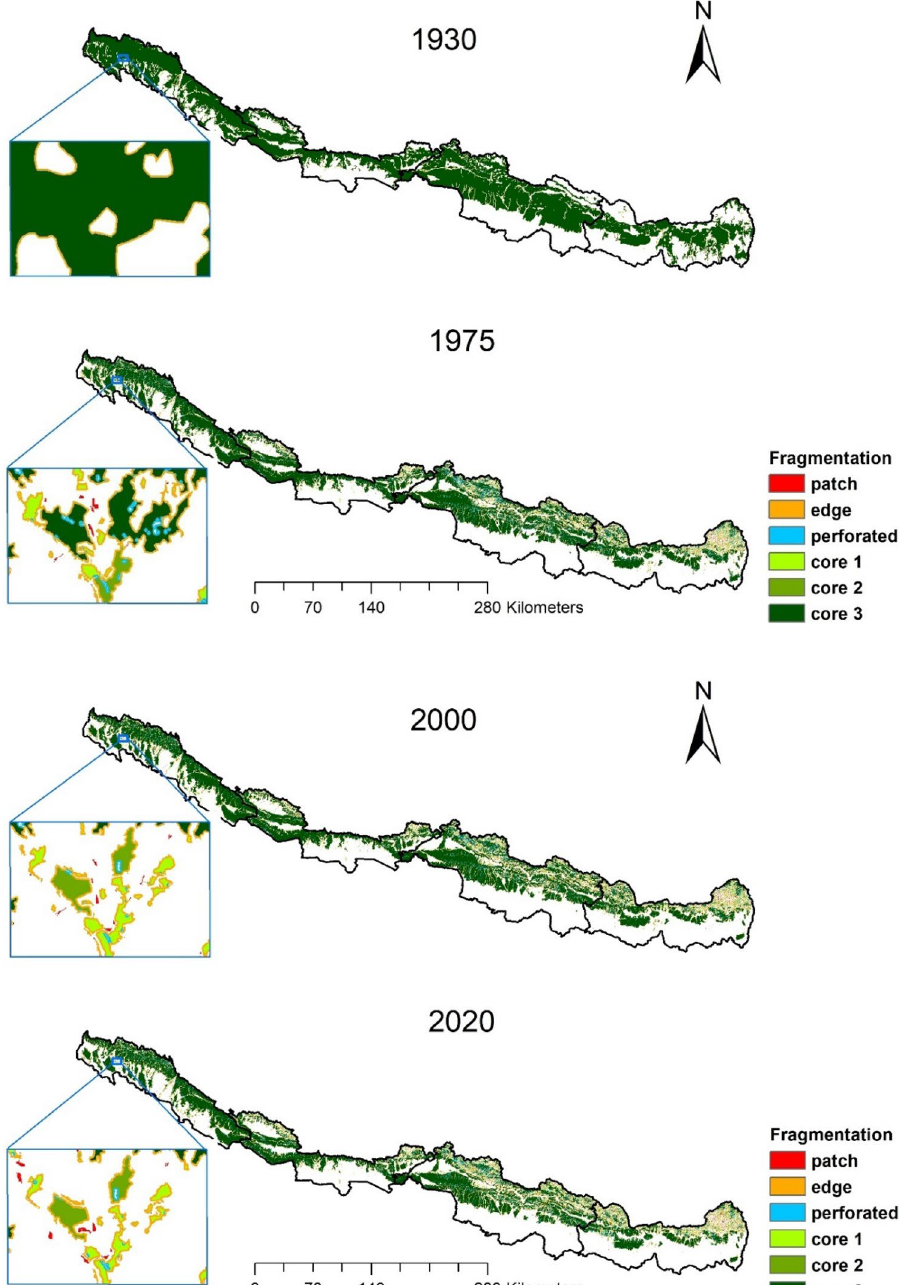
Figure 2. Habitat (forest) fragmentation of Asian elephants in the Chure Terai Madhesh Landscape, Nepal. Inset shows an enlarged view of habitat fragmentation in four different periods (1930, 1975, 2000 and 2020) at that particular location. Map generated by Ashok Kumar Ram using ArcGIS 10.5 101